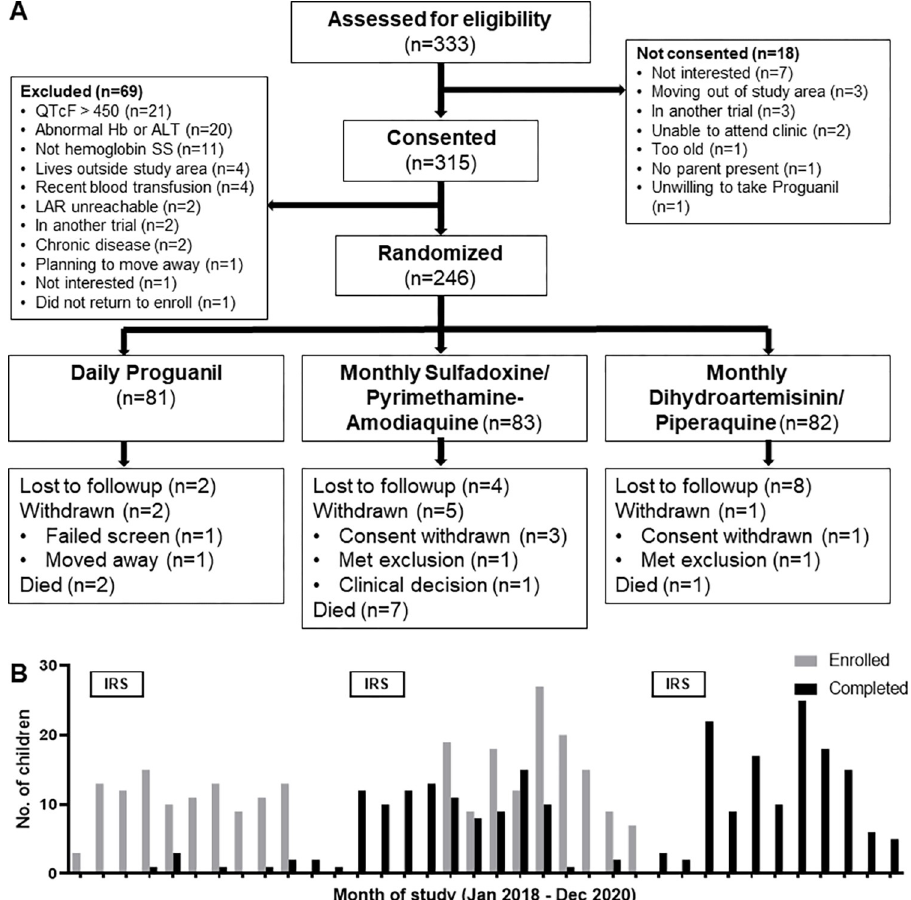
Fig 1. Screening, randomization, enrollment, and follow-up. ( A ) Patient flow diagram. ( B ) Monthly enrollment (gray bars) and completion (black bars) of participants. Bars labeled IRS indicate the months in which IRS activities were implemented as malaria control in the study community by health authorities. ALT AU : AbbreviationlistshavebeenupdatedinFigs 1 and 2 : Pleasecheckandverifythattheaddedentriesarecorrectlyabbreviated : , alanine aminotransferase; Hb, hemoglobin concentration; IRS, indoor residual spraying; LAR, legally authorized representative; QTcF, QT interval corrected for heart rate using Fridericia’s